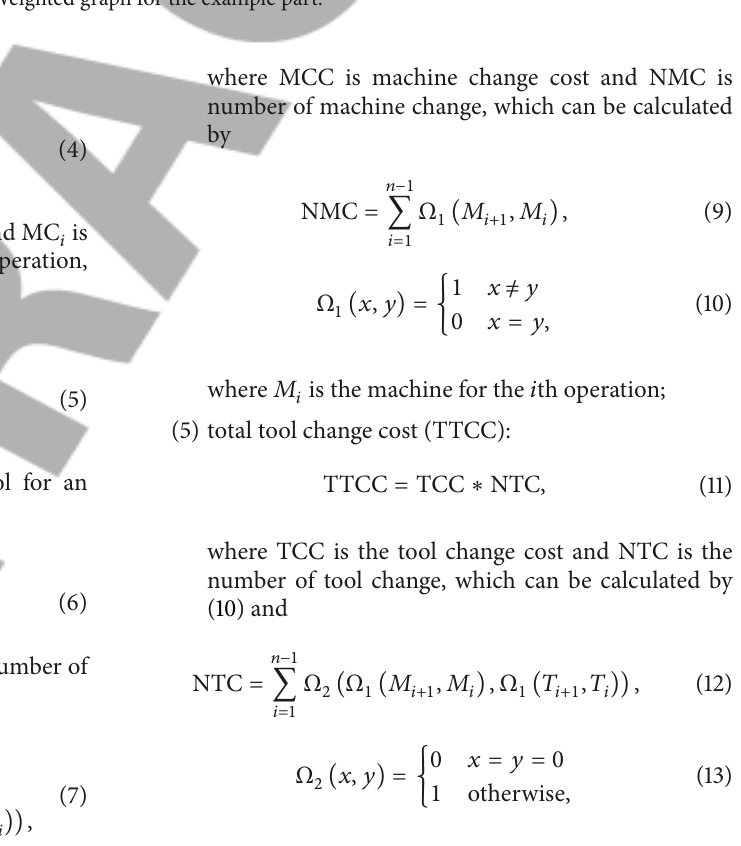
Figure 2: Weighted graph for the example